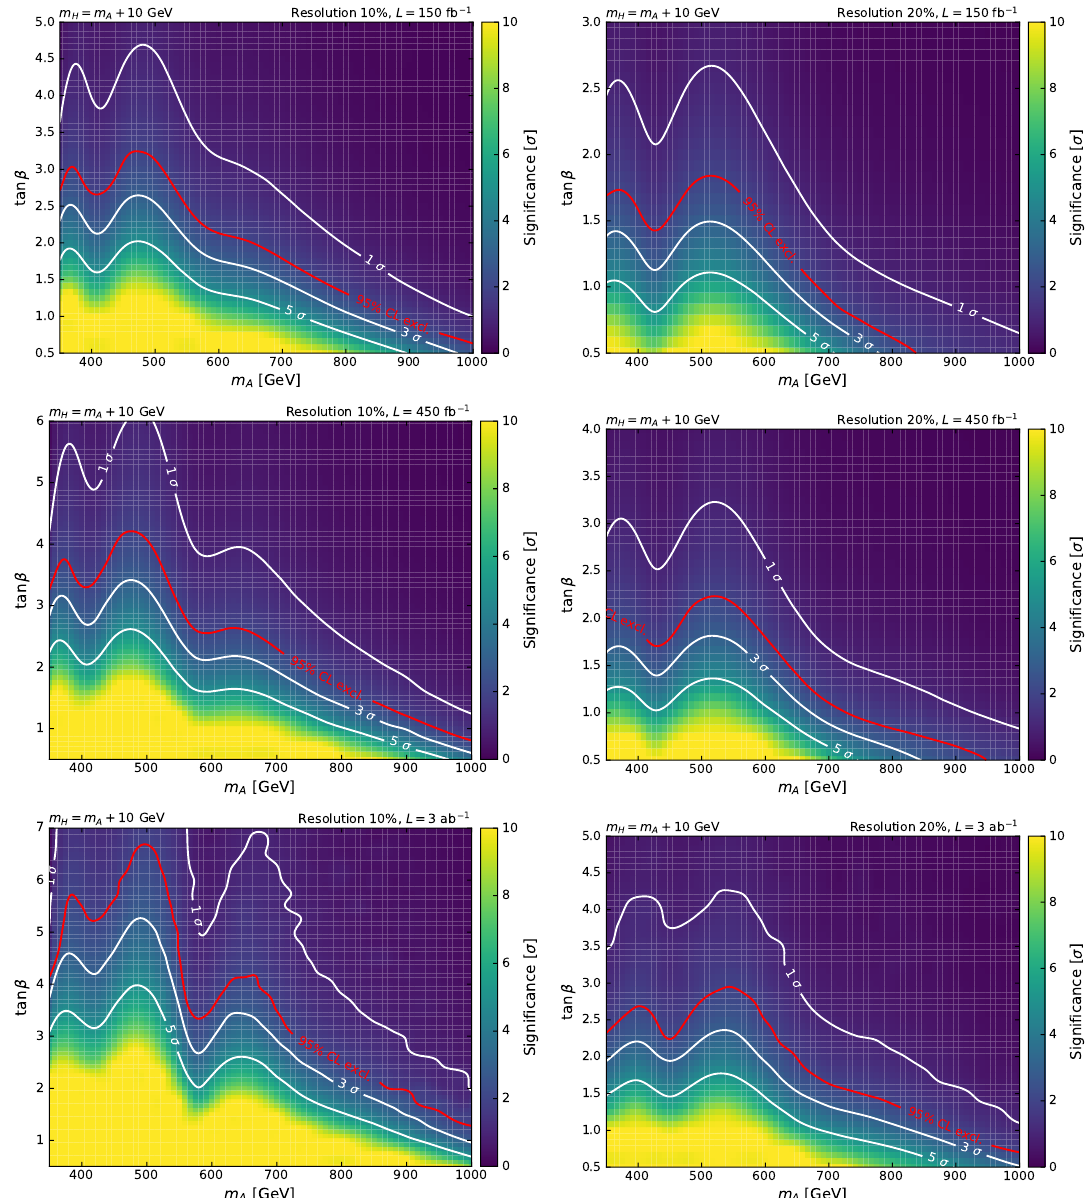
Figure 12 . Expected signi(cid:12)cance and exclusion potential for a Type II 2HDM with a mass splitting M H (cid:0) M A = 10 GeV in the same six experimental scenarios as considered in (cid:12)gure 10. Values of signi(cid:12)cance in excess of 10 (cid:27) are clipped. A resolution of 10% and 20% is assumed for the left- and the right-hand side plots,